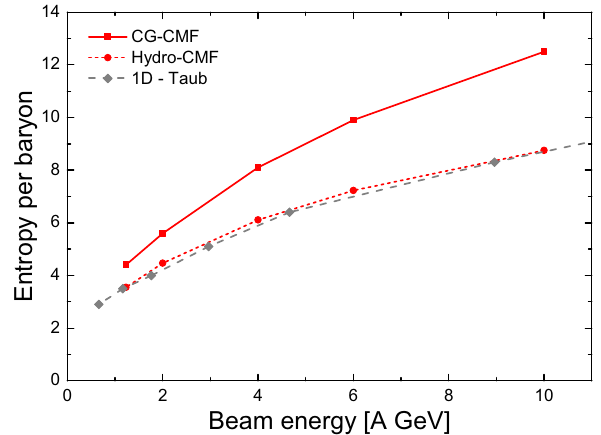
Fig. 7 Entropy production per baryon as a function of beam energy for central Au+Au reactions in the energy range from E lab = 1 . 23 A GeVto10 A GeV.Thelinesdenotecalculationsusingthecoarsegrained UrQMD model withCMFEoS (fullredline),aone-fluidhydrodynamics calculation (dotted red line) and the one-dimensional shock model, i.e. the Taub adiabate (dashed grey